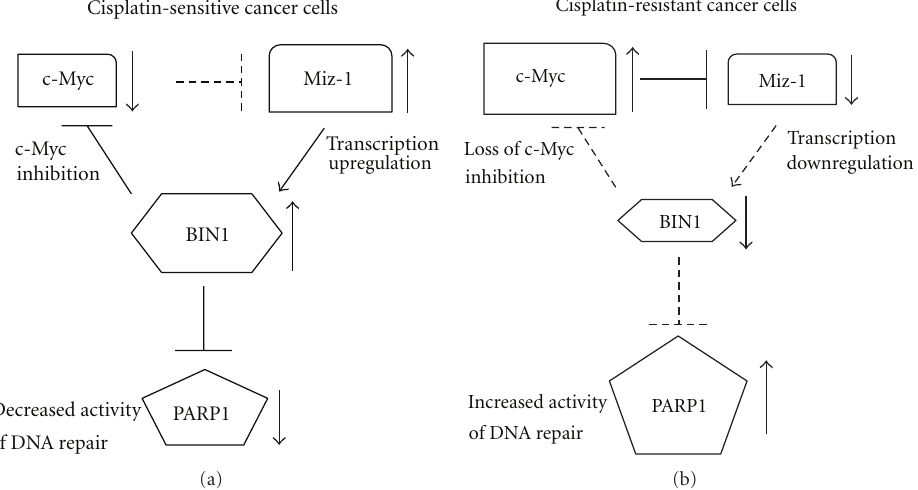
Figure 3: The molecular mechanism by which BIN1 is involved in cisplatin sensitization. Quoted from [5] and modified. The Miz-1-BIN1 interaction upregulates cellular cisplatin sensitivity by disruption of PARP1 activity. In cisplatin-sensitive cancer cells, a low level of c-Myc allows Miz-1 to stimulate BIN1 transcription, thereby maintaining a high cellular level of BIN1. The feedback inhibition of c-Myc by BIN1 perpetuates the decrease in c-Myc levels and results in decreased PARP1 activity, which consequently leads to downregulation of DNA repair activity. (b) In cisplatin-resistant cancer cells, c-Myc overexpression represses BIN1 expression by blocking the transcription activity of Miz- 1. Loss of BIN1 feedback inhibition results in a robust increase in endogenous c-Myc and PARP1 activities, which consequently up-regulates DNA repair activity and cancer cell resistance to cisplatin. (a, b) Dashed lines indicate a decrease in the abundance or activity of a (positive or negative) regulator. Arrows indicate transcriptional up- or downregulation. Arrow size indicates the strength of this